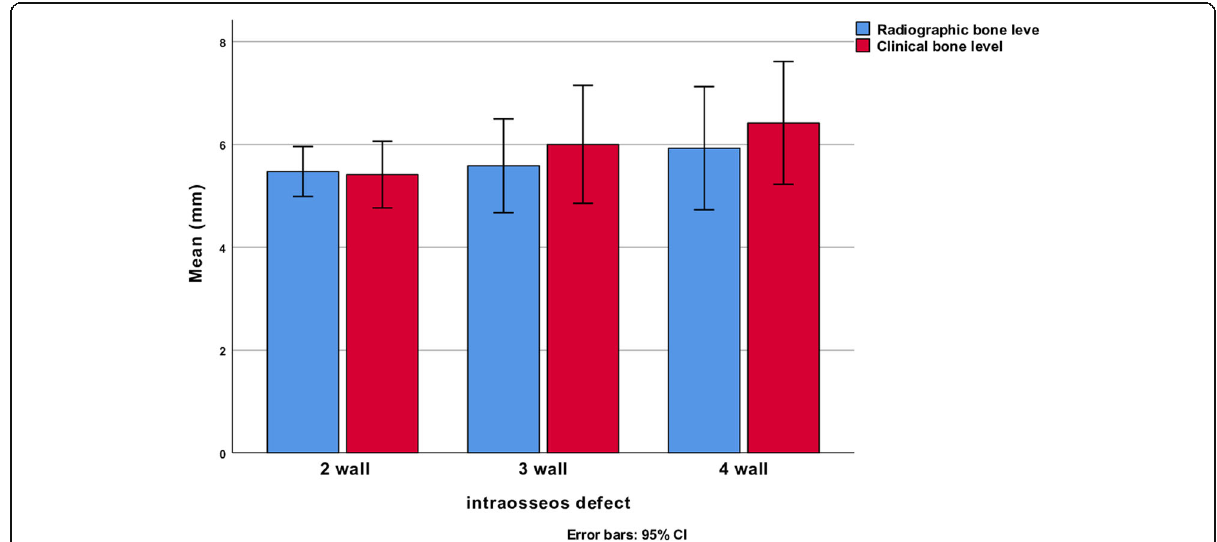
Fig. 3 Comparison between radiographic and clinical bone level measurements at the time of surgery